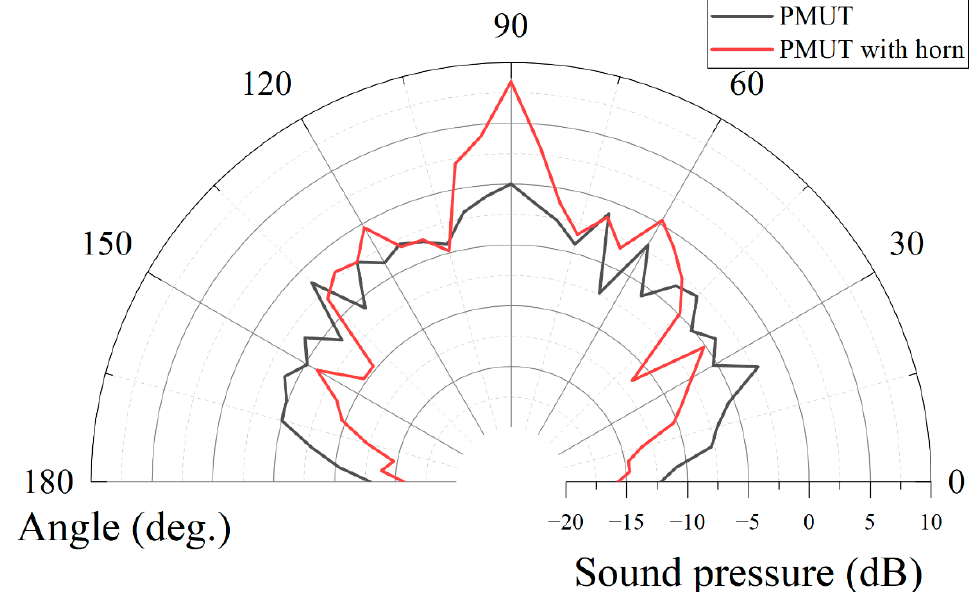
Figure 7. Directivity characterization of PMUT array: the directivity without horn ( black ), half- power-beam-width θ − 3dB is 100°. The directivity of PMUT with horn ( red ), half-power-beam-width θ − 3dB is 20°. Adding the horn can focus the energy to increase the output sound pressure and reduce the sound field angle to avoid unnecessary objects during the long-distance measurement.